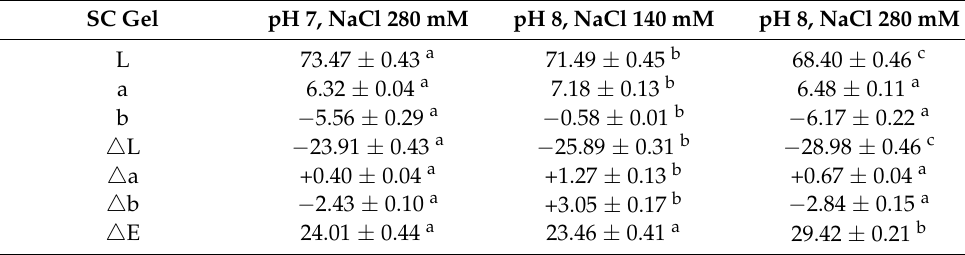
Table 3. Chromatism of skin collagen (SC) gels from C. idella under different salinity and pH conditions. SC